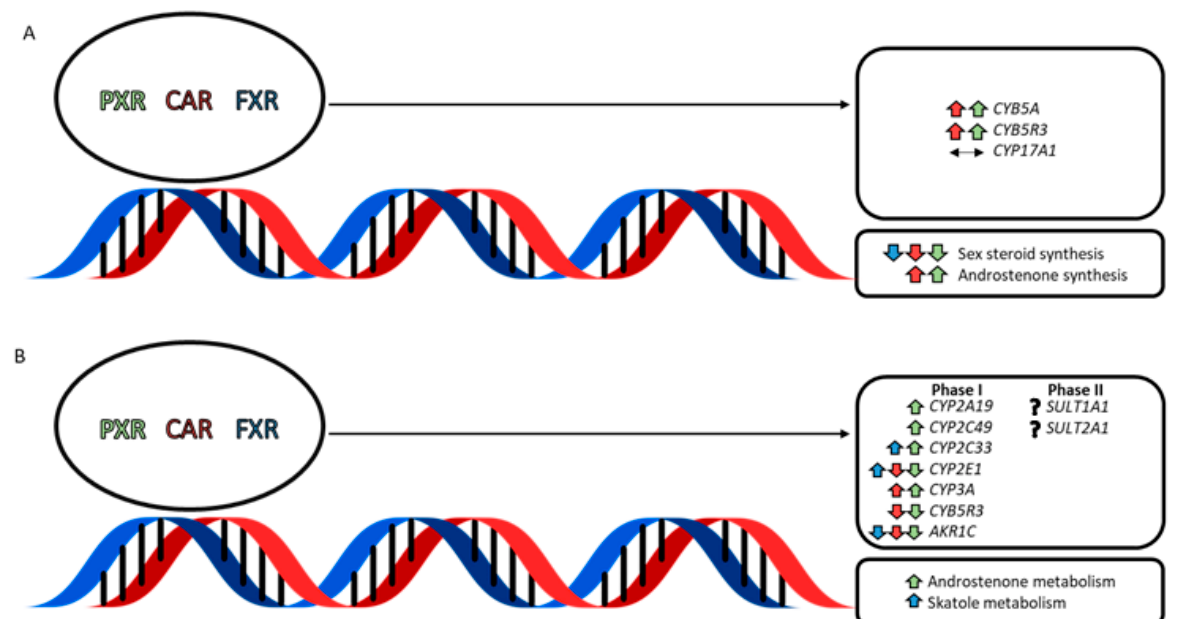
Figure 1. The effects of nuclear receptor activation reported by Gray and Squires [37,38] in porcine ( A ) Leydig cells [37] and ( B ) hepatocytes [38]. PXR, CAR, and FXR, shown in green, red, and blue, respectively, increase ( ↑ ) or decrease ( ↓ ) the expression of genes in the testis that regulate steroidogenesis and Phase I and II metabolism in the liver. Symbols in black represent no effect ( ↔ ) or no characterized effect (?) of PXR, CAR, or FXR on the genes of interest. The overall effect on the synthesis or metabolism of androstenone and skatole is shown.